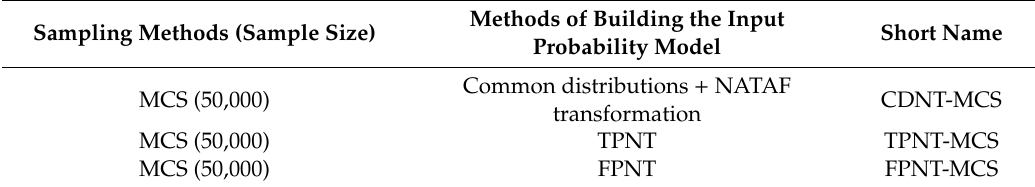
Table 4. The comparison